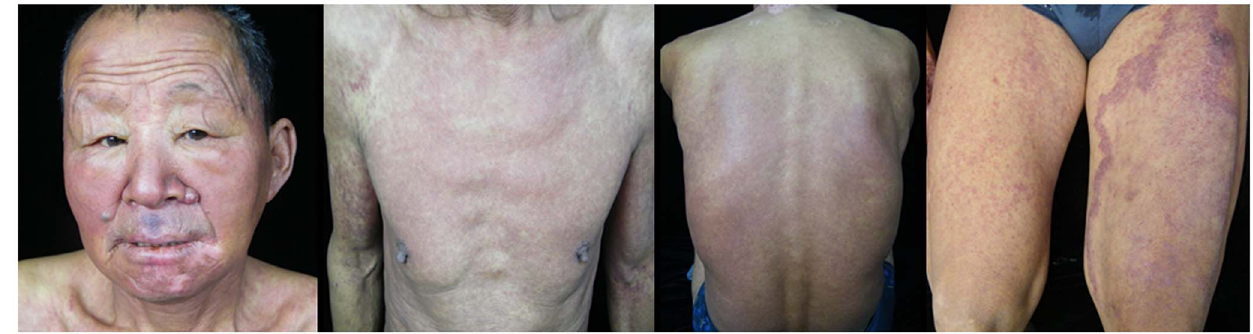
Figure 2. Clinical manifestations of the first patient when he suffered DDS syndrome. Generalized purpuric rash could be found on the face and trunk, and the lesions on the right leg were aggravated.